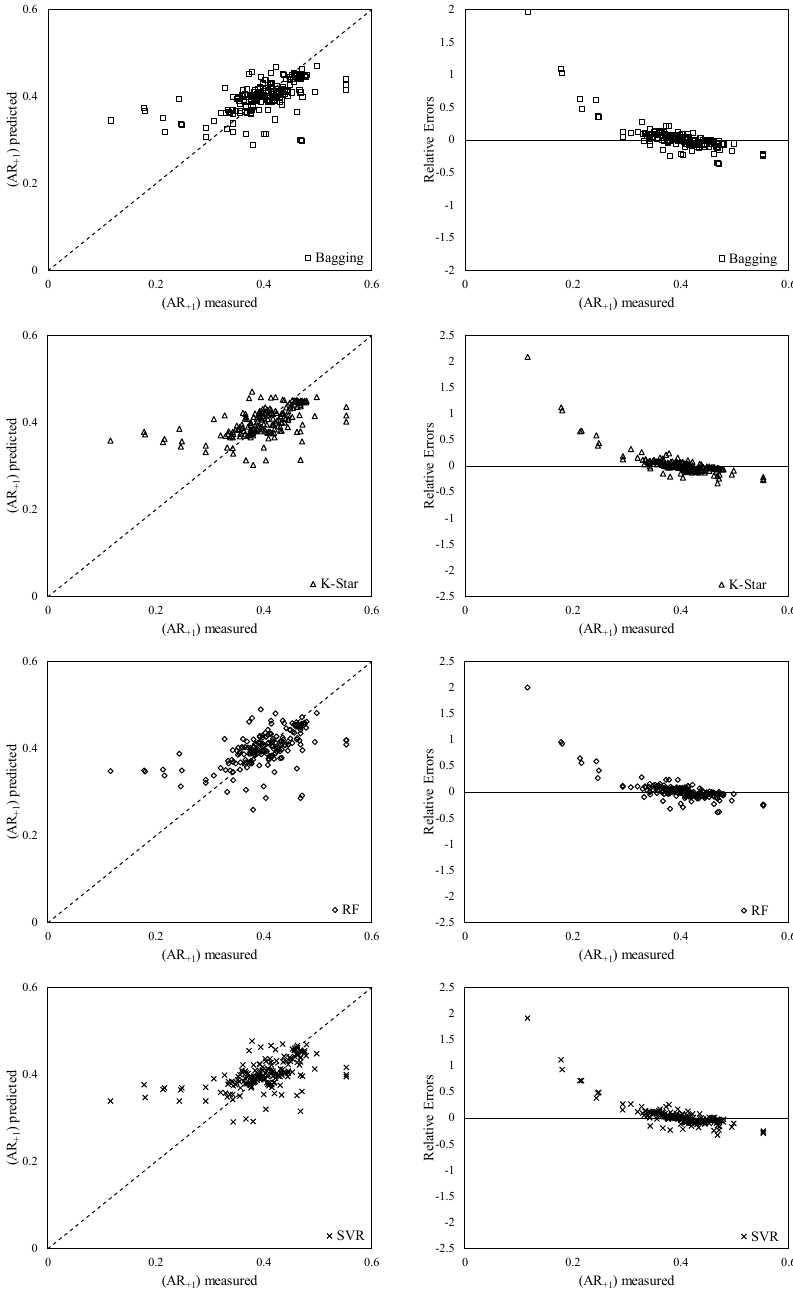
Figure 10. Aspect ratio prediction “Model 1”: in the left column, predicted versus experimental values, in the right column, residuals versus experimental values.